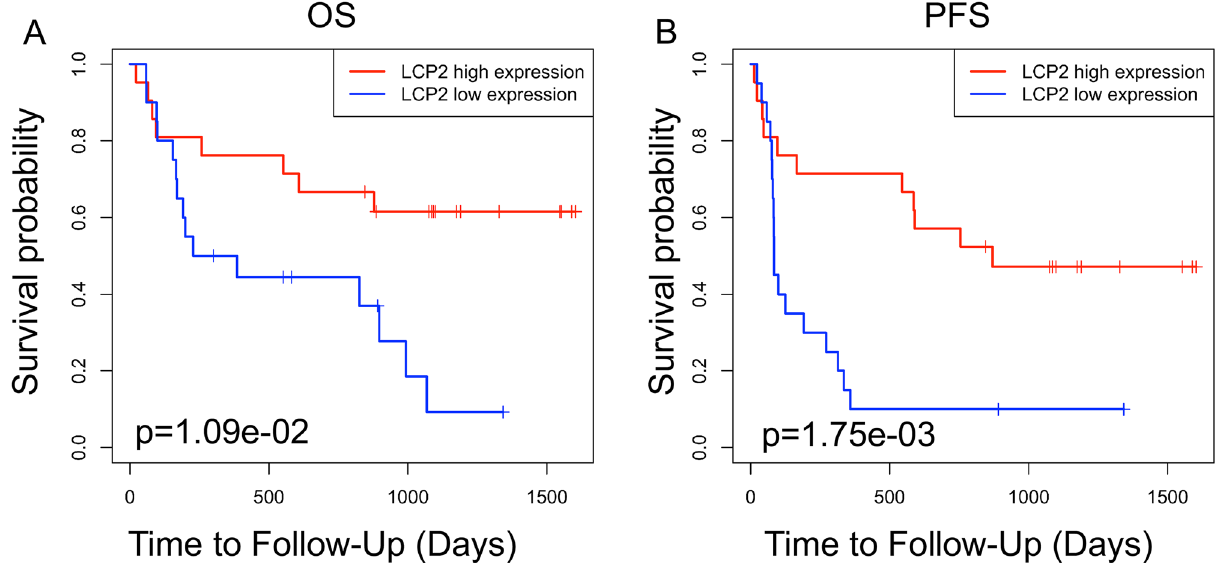
Figure 9. Prognostic value of LCP2 in melanoma patients receiving immune checkpoint blockade. Kaplan– Meier curves of OS ( A ) and PFS ( B ) for patients with low and high expression of LCP2 in the Gide2019_PD1 cohort who received anti-PD-1 immunotherapy. OS overall survival, PFS progression-free